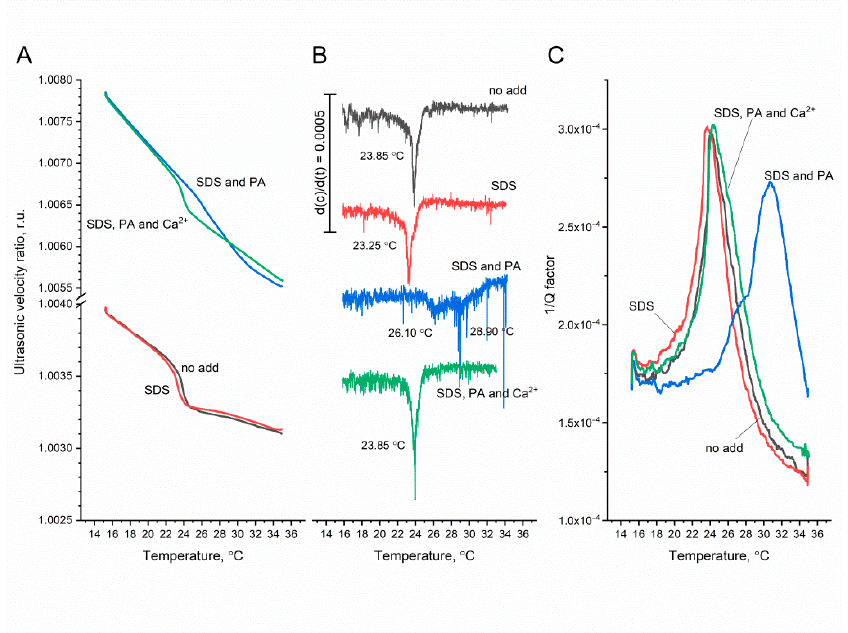
Figure 5. Effect of sodium dodecyl sulfate (SDS), palmitic acid (PA), and Ca 2+ on the phase state of dimyristoylphosphatidylcholine liposomes. Dependence of the relative velocity of ultrasound ( A ), its derivative ( B ), and the 1/Q-factor ( C ) on temperature. Measurements were performed in the medium containing 50 mM KCl, 20 μ M EGTA, 10 mM Tris-HCl (pH 8.5), and 1% ethanol (added with palmitic acid).